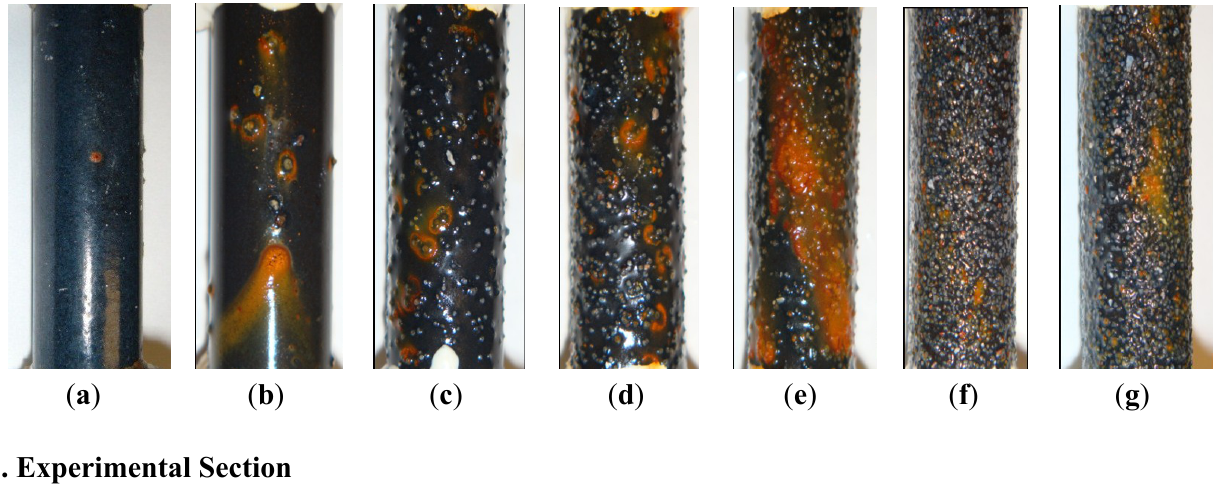
Figure 8. Surface conditions of enamel-coated steel bars after seven days of immersion in 3.5 wt% NaCl solution: ( a ) 0%; ( b ) 5%; ( c ) 10%; ( d ) 20%; ( e ) 30%; ( f ) 50%; and ( g ) 70% sand